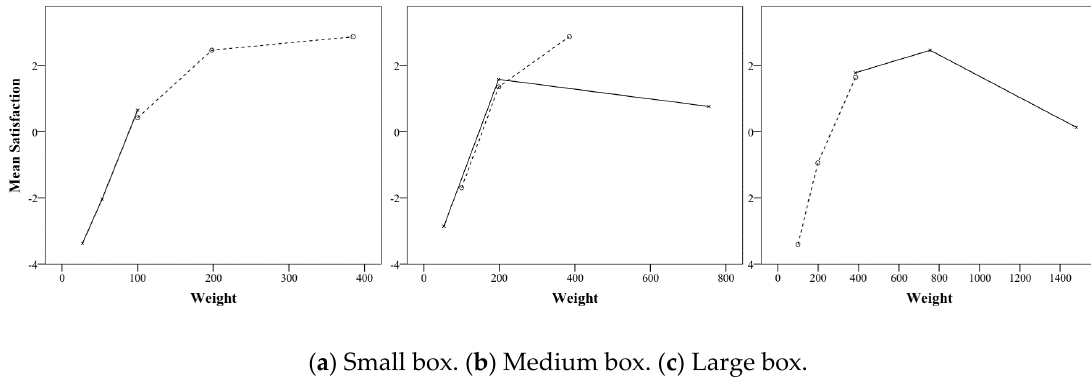
Figure 8. Mean satisfaction of weights for each box size (the dashed line is the first experiment, and the solid line is the second experiment).